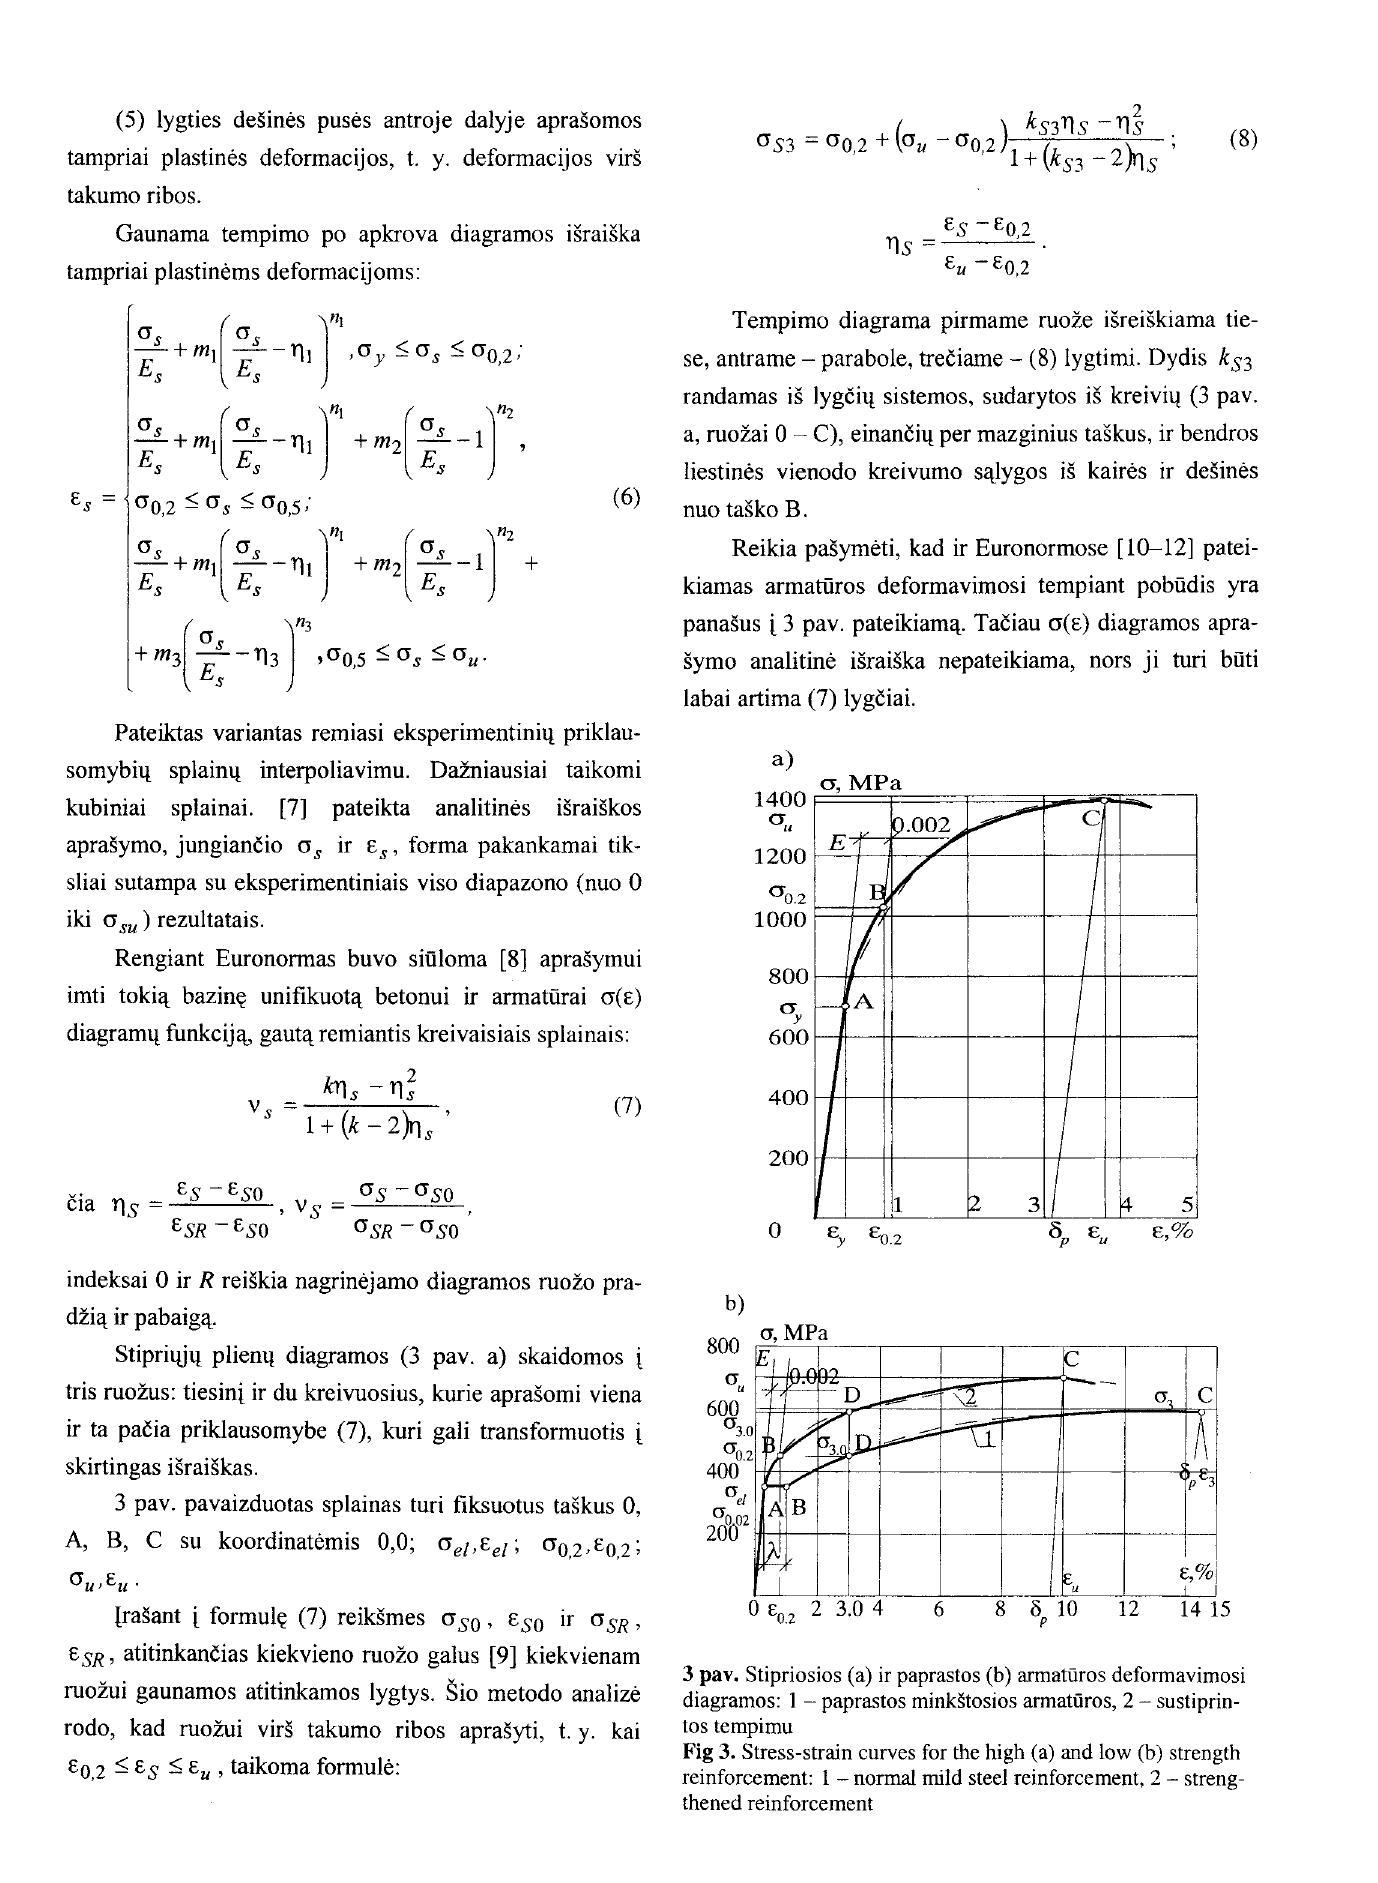
(5) lygties desines puses antroje dalyje aprasomos tampriai plastines deformacijos, t. y. deformacijos virs takumo ribos.